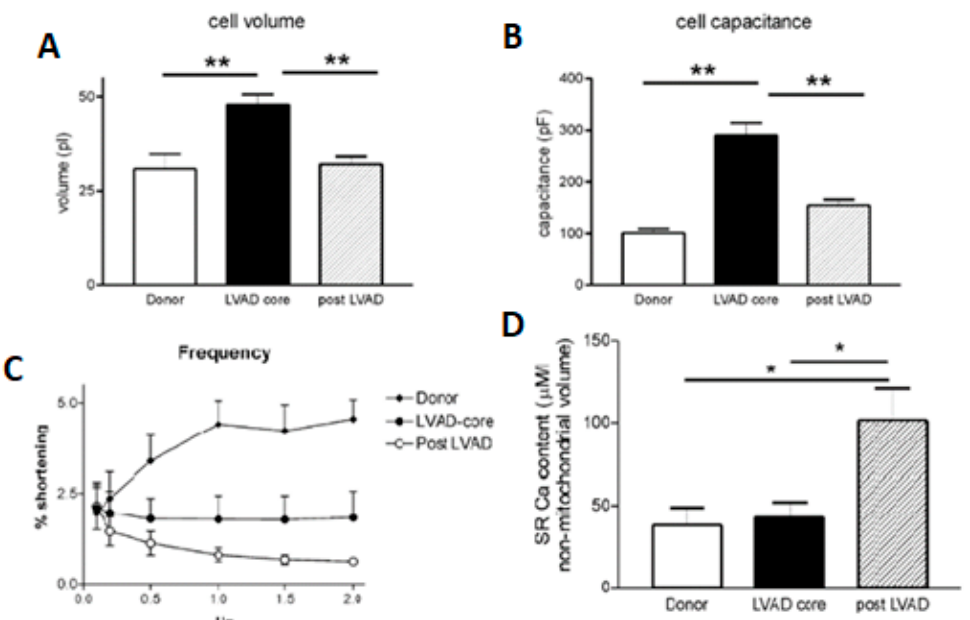
Figure 3. After LVAD placement ( A ): cell size and ( B ): capacitance (an index of cell surface area), tend to return to normal donor values, indicating reversal of hypertrophy. ( C ): No increase in the contraction-frequency-dependent relationship was observed in patient cells with or after LVAD use in contrast to donor cells. As a result, the researchers hypothesized the involvement of calcium transport mechanisms as responsible for the improvement in contraction. ( D ): LVAD-implanted HF patients show reduced calcium current amplitude compared to LVAD-removal patients and no-difference compared to donors. After LVAD removal there is an increase in the amount of calcium observed compared to heart failure patients and donors. The LVAD increases the amplitude of the calcium current and its quantity, improving the excitation-contraction relationship of the cardiomyocyte, being a mechanism for promoting cardiac recovery. * p < 0.05; ** p < 0.01; LVAD core: left ventricular tissue taken at LVAD implant; post LVAD: left ventricular tissue taken at LVAD removal. Reprinted with permission from Terracciano CMN, et al., (2003), Copyright © 2003, Oxford University Press [27].